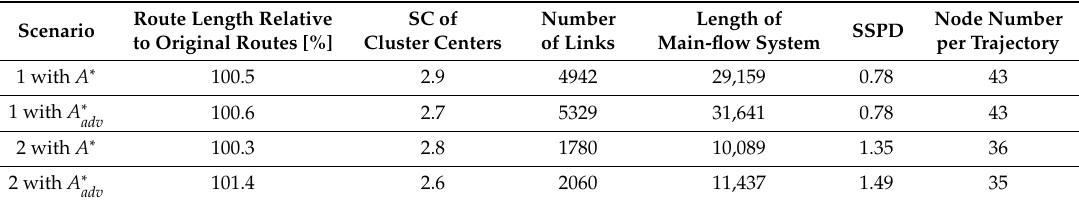
Table 8. Results for 𝐴 ∗ and 𝐴 𝑎𝑑𝑣∗ for both scenarios. All values are medians.